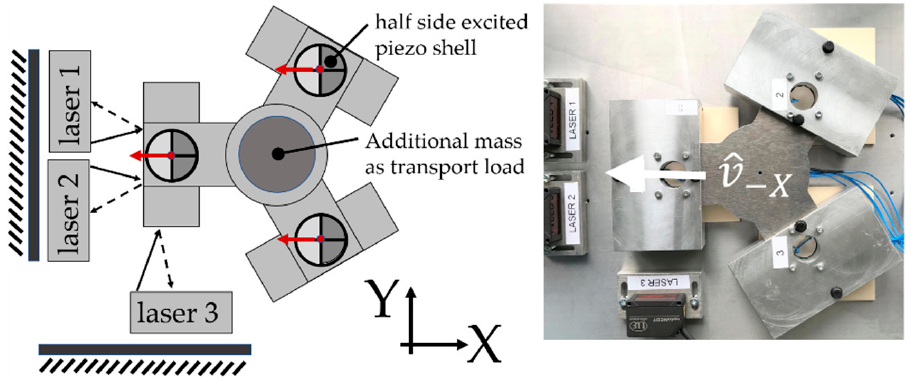
Figure 8. Setup for drive speed measurements of the planar motor platform.